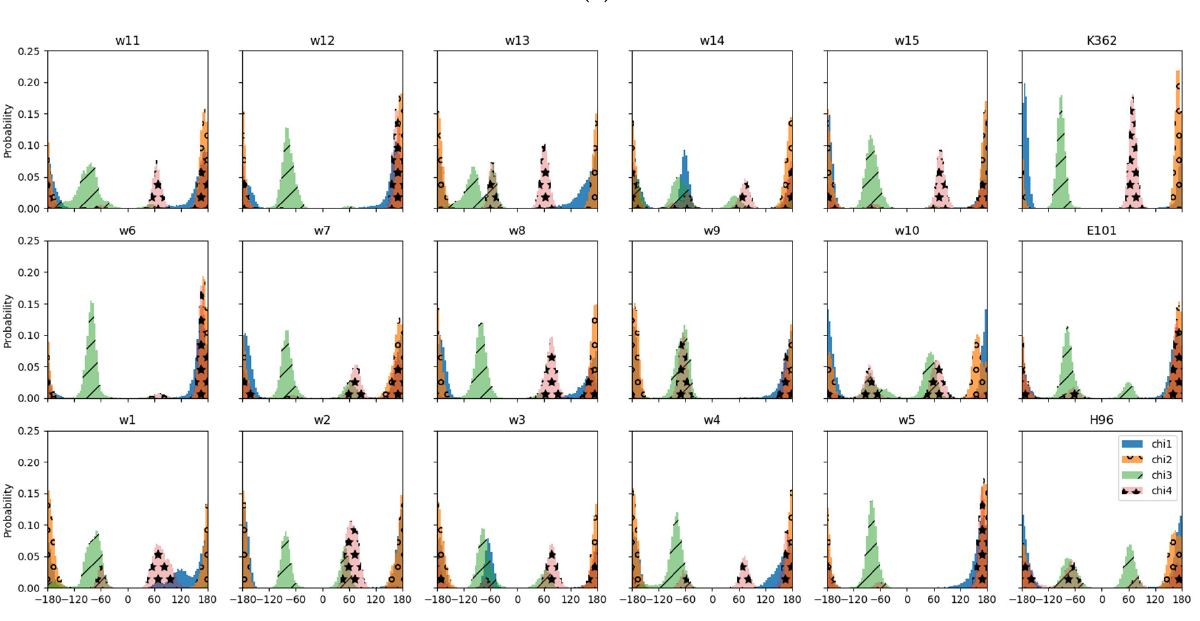
Figure 3b in latex file is named as : diheK362_20000.png Figure 3. Distribution of side chain dihedral angles, χ 1 , χ 2 , χ 3 , and χ 4 of residue K362 in the MD simulations with the excess proton located at different sites. ( a ) Simulations of the reduced model based on a snapshot with K362 in an “up” position, and ( b ) simulations of the reduced model based on a snapshot with K362 in a “down” newest version of supplementary, please help to update online. Thanks very much.